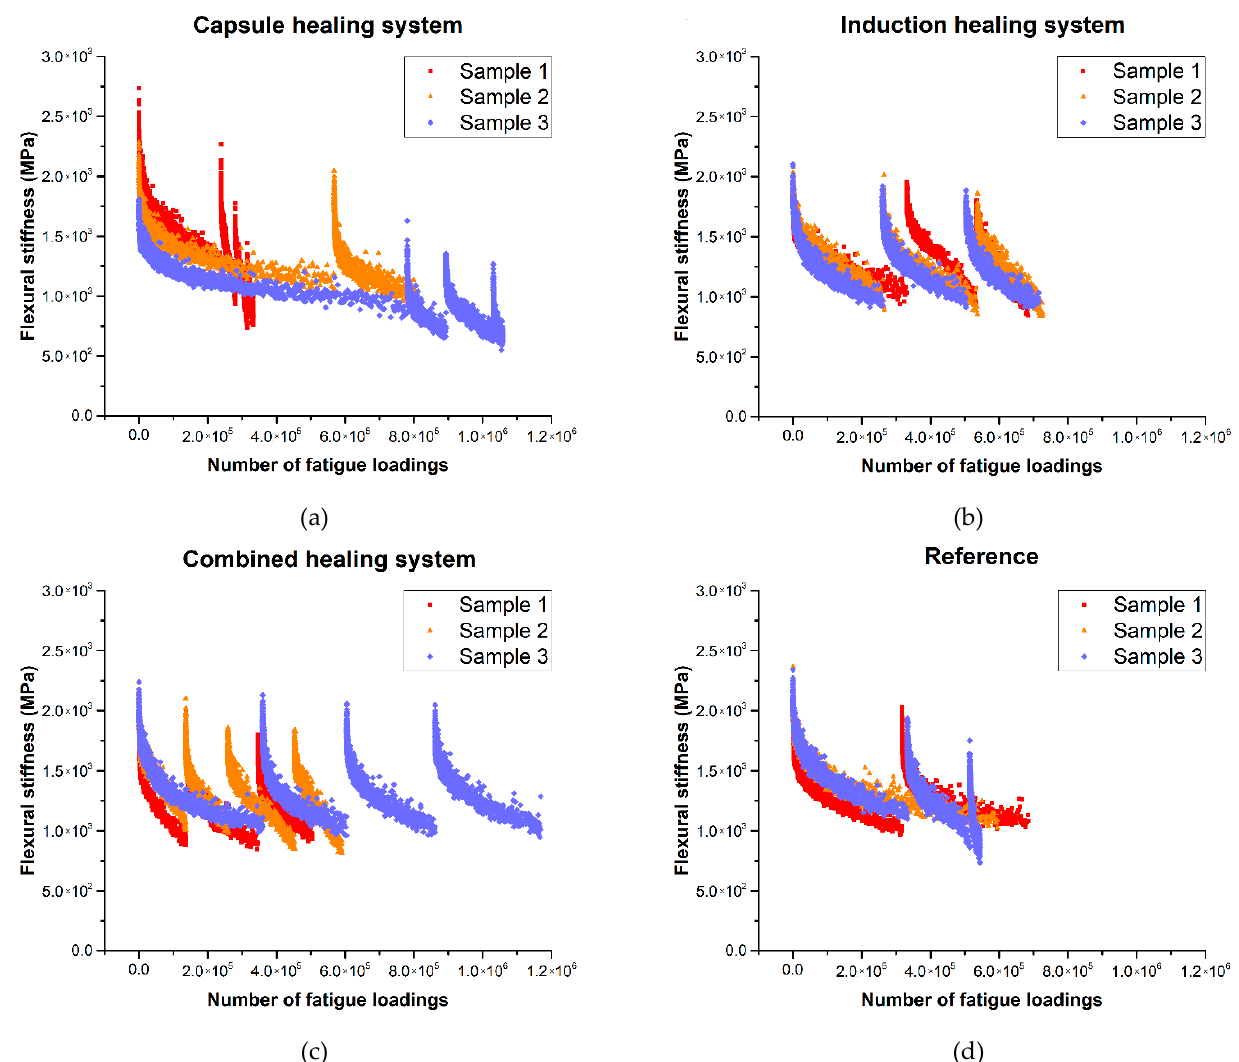
Figure 15. Four-point bending fatigue test results for the aged mixture with various healing systems: ( a ) the capsule healing system, ( b ) the induction healing system, ( c ) the combined healing system and ( d ) the reference mix.